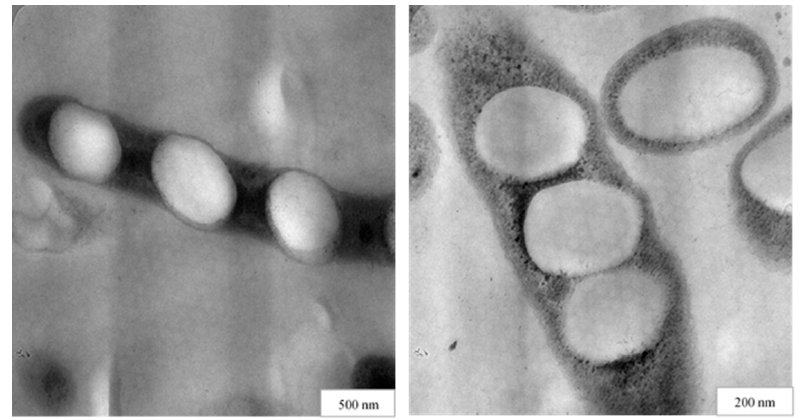
Figure 8. TEM image of nanosized PHA granules inside bacterial cells.